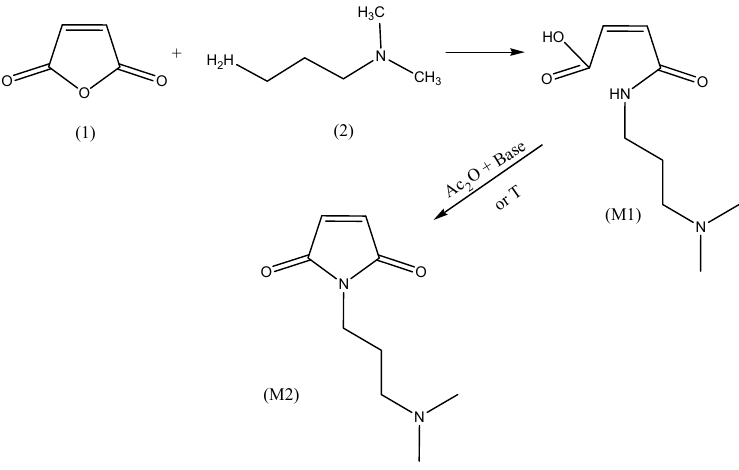
Scheme 3. Model reaction of amidoacidification and imidization of maleic anhydride with -(dimethylamino)-1-propylamine (DMAPA).